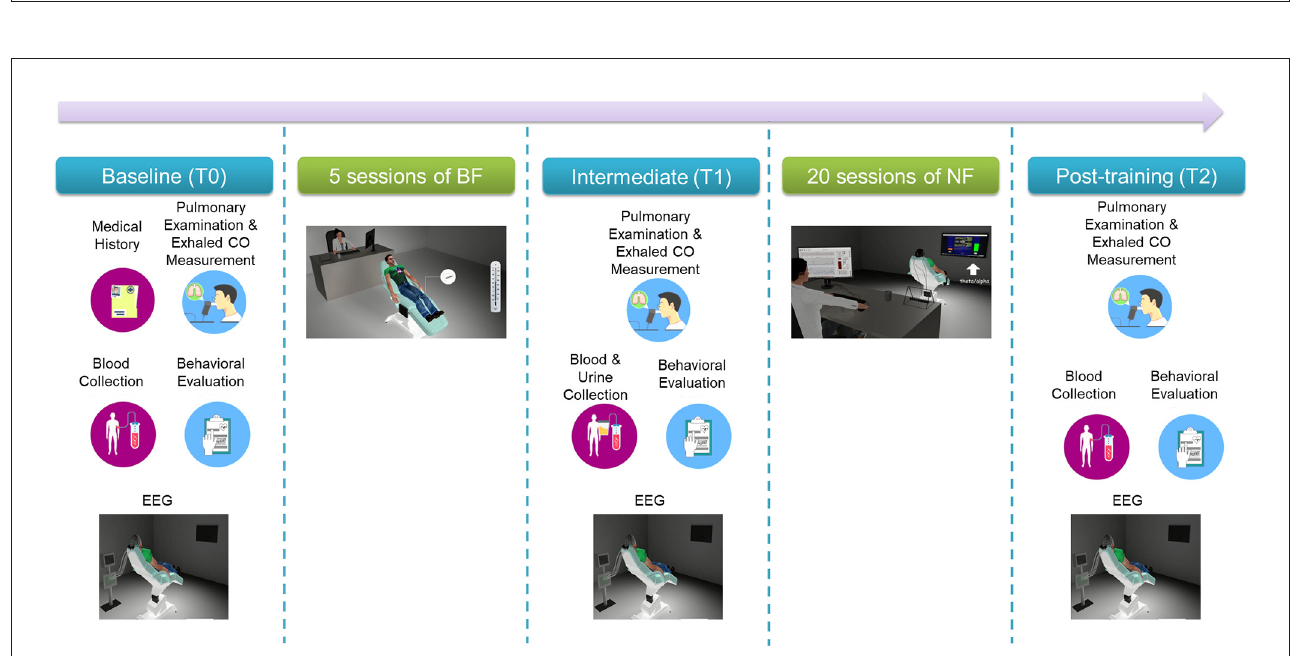
FIGURE2 Overview of the experimental